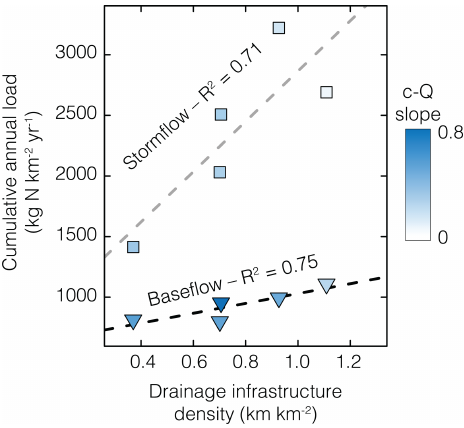
Figure 7. For all five watersheds, cumulative annual load exported during stormflow (squares) and baseflow (triangles) periods as a function of the drainage infrastructure density. Shapes are colored by the average c – Q slope for stormflow and baseflow periods, with darker blues associated with more chemodynamic export